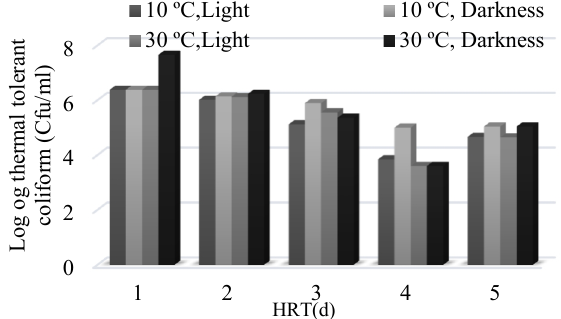
Fig. 3. Changes in thermophilic coliform in FAS under different conditions (pH =